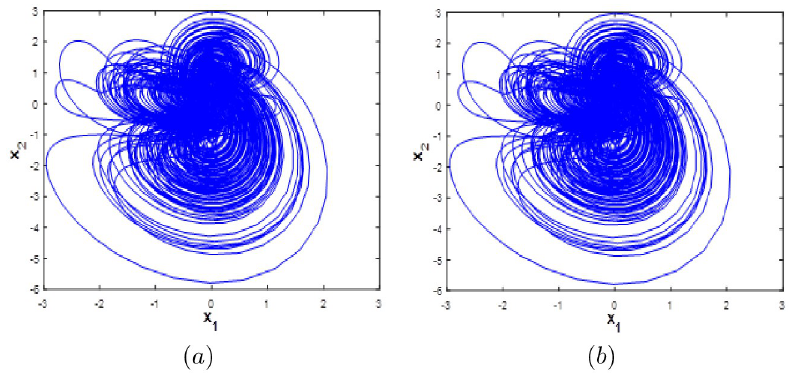
Fig 19. Phase portraits of the hyperchaotic system (19): (a) x 1 − x 2 attractor, (b) x 1 − x 3 attractor.